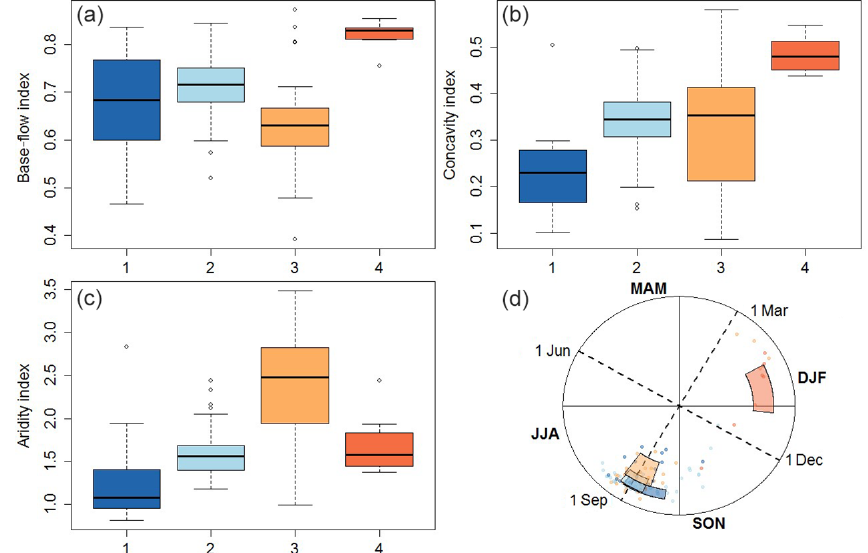
Figure 11. Statistical distribution of the discriminating factors identified by the CART algorithm (a–c) and the mean timing θ of daily discharge below Q 95 and its dispersion r (d) . The boxplots are defined by the first quartile, the median and the third quartile. The whiskers extend to 1.5 of the interquartile range; open circles indicate outliers. The colour is associated to the membership to one class, and the name of the class is given along the x axis. The coloured areas in (d) are defined by the first quartile and the third quartile of r and θ . Each dot is related to one gauged basin. The dotted lines indicate the start of four meteorological